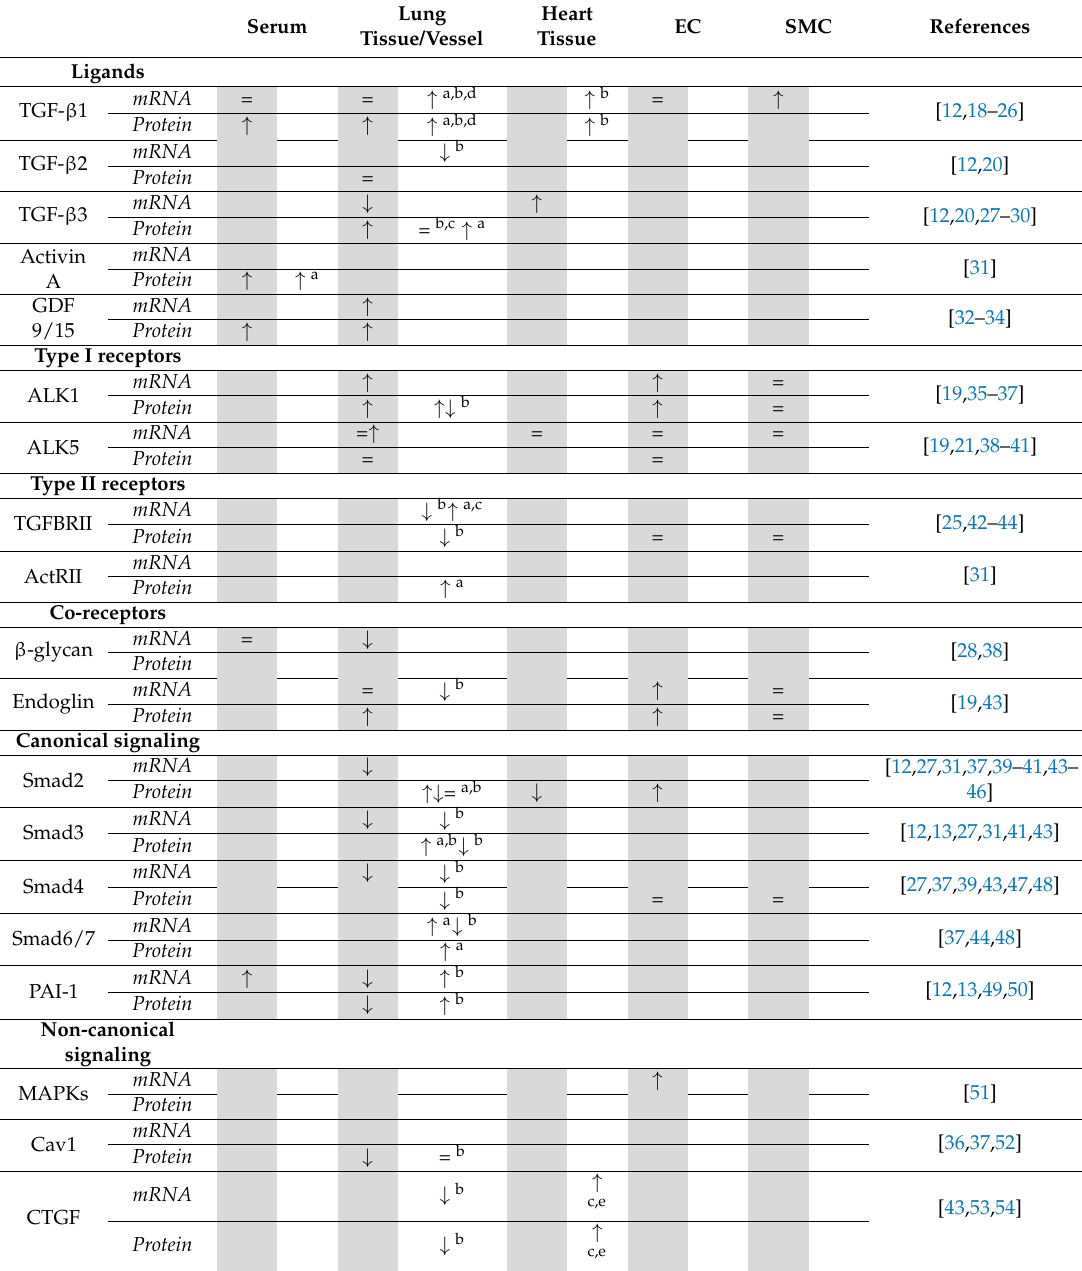
Grey boxes indicate findings in tissue of pulmonary arterial hypertension patients; white boxes indicate findings in experimental animal models. ↑ , increase in comparison to controls; ↓ , decreased in comparison to controls; =, no change in comparison to controls. ( a ) Hypoxia-induced PH in rat, ( b ) monocrotaline-induced PH in rat, ( c ) Sugen hypoxia-induced PH in rat, ( d ) Schistosoma -induced PH in mice, ( e ) pulmonary artery banding